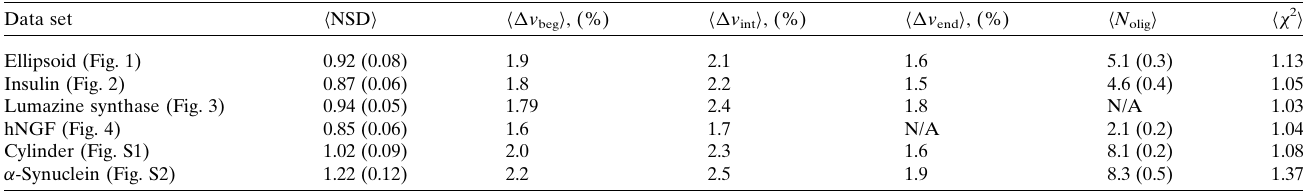
Table 1 Results of multiple runs of DAMMIX (in all cases, 15 individual runs) for synthetic and experimental data sets. The second column reports the average h NSD i values between pairwise superimposed models obtained from different DAMMIX runs for intermediate species; h (cid:2) v beg i , h (cid:2) v int i and h (cid:2) v end i are average dispersions of volume fractions for initial, intermediate and final states of the systems, respectively; h N olig i is the average oligomerization number for the intermediate species; h (cid:2) 2 i are the average differences of the restored curves from intermediate species obtained by DAMMIX , where the corresponding errors in brackets were estimated from the Poisson